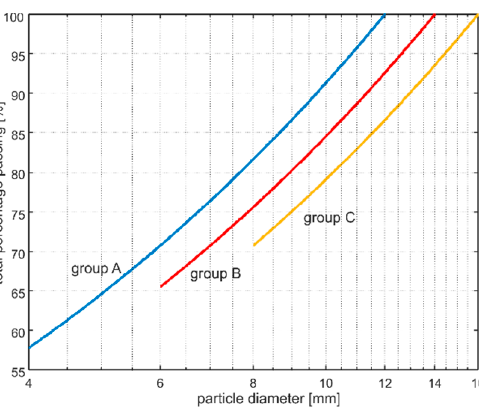
Figure 5. Fuller’s curves for concrete models considered in the study.